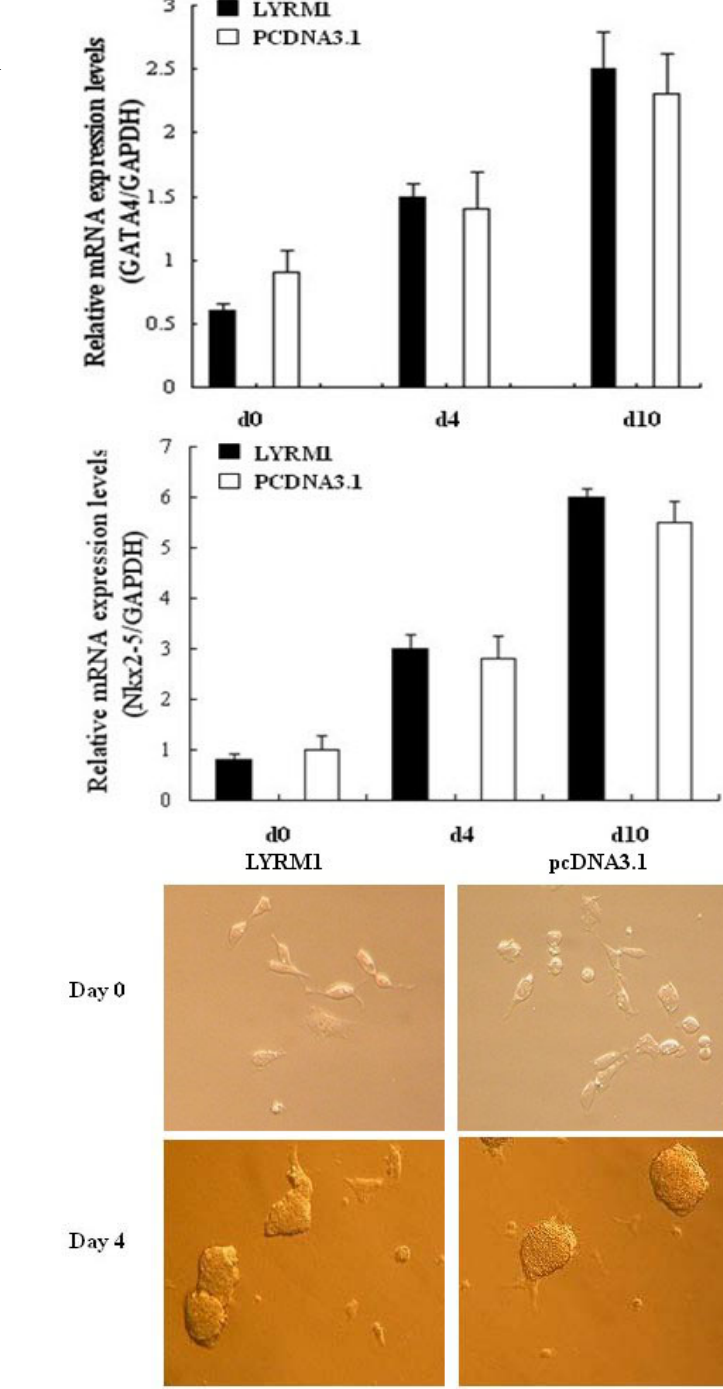
Figure 1. Effect of LYRM1 on cell differentiation. (A) Expression of specific differentiation markers as determined by quantitative real-time RT-PCR at various time points during the stimulation of differentiation (days 0, 4, and 10). No difference in the expression levels of these markers was found between cells with or without exogenous expression of LYRM1 (n = 6; P < 0.05). (B) Morphology of P19 cells during differentiation (days 0, 4, and 10). P19 cells were transfected with pcDNA3.1Myc/HisB-LYRM1 or an empty vector and stimulated to differentiate over 10 days. This experiment is representative of three independent